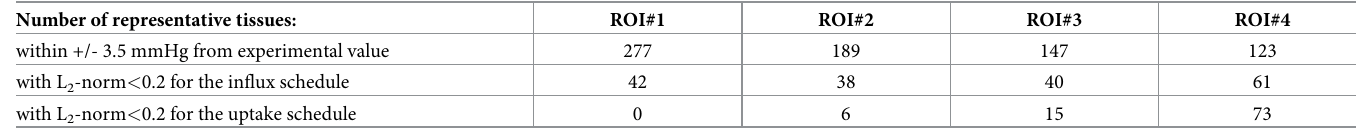
Table 3. Number of tissues representing each ROI and tissues fitting each fluctuation. Number of representative tissues: